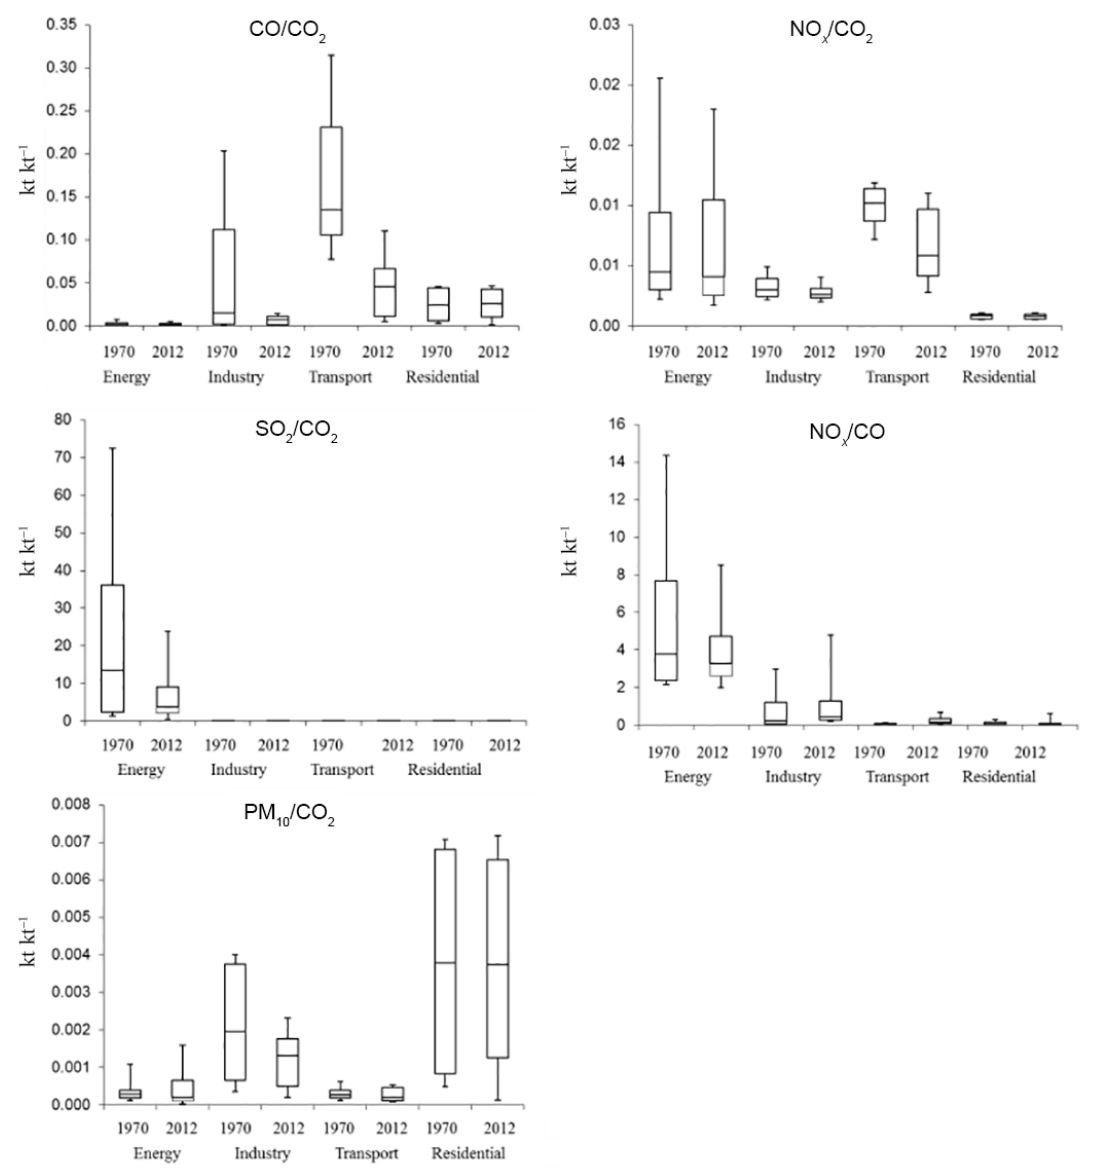
Figure 11. Comparison of 1970 and 2012 global emission ratios of CO / CO 2 , NO x / CO 2 , SO 2 / CO 2 , NO x / CO, and PM 10 / CO 2 (expressed in ktkt − 1 ) for different sectors. Box plots are calculated, including all world countries, and represent the 10th, 25th, 50th, 75th, and 90th